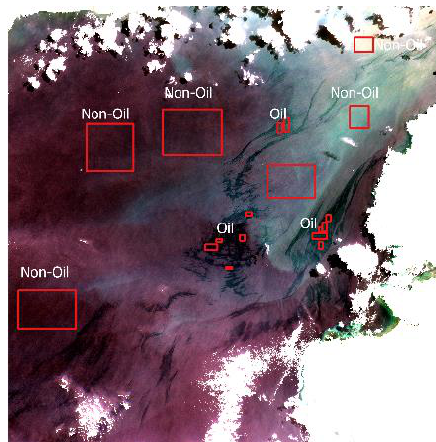
Figure 4. Location of pixels selected as oil and non-oil.